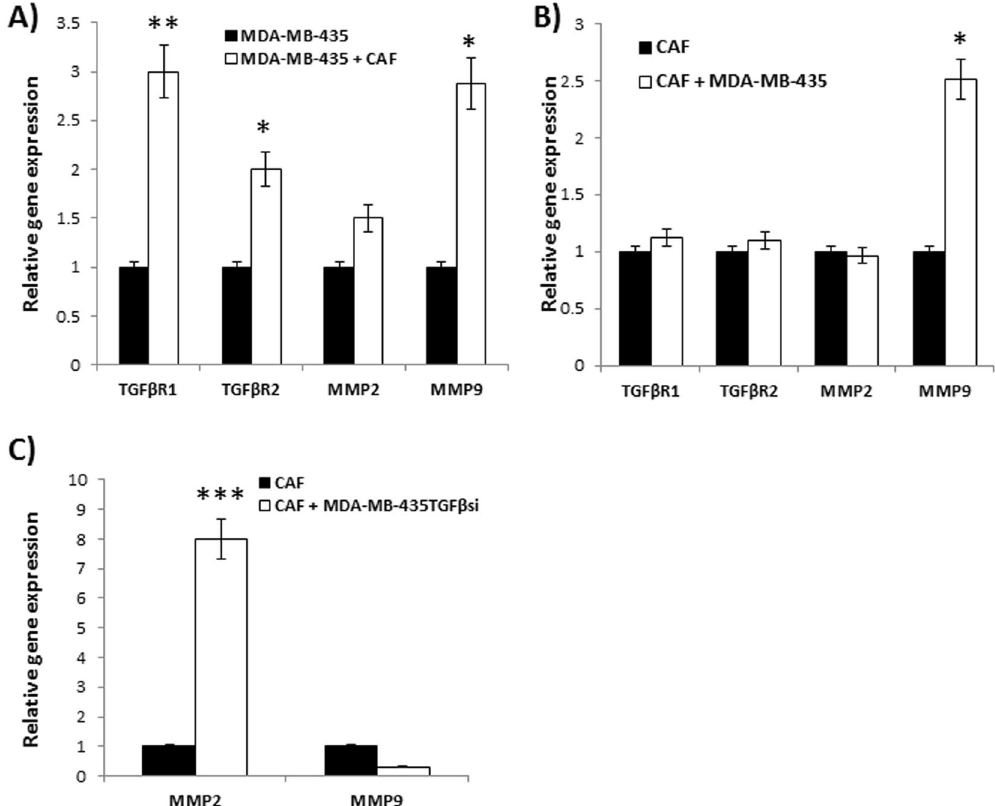
Figure 4. Co-culture assays to determine the effects of paracrine signaling on tumor and stromal cell gene expression. MDA-MB-435 cells and MDA-MB-435 TGF- β si cells were co-cultured with fibroblasts in Boyden chambers. Forty-eight hrs later, RNA was collected from both the tumor and fibroblasts for RT-PCR analysis of TGF- β 1, TGF- β 2, TGF- β 3, TGF β RI, TGF β RII, MMP-2 and MMP-9 gene expression levels. Values provided in ( A ) indicate gene expression from MDA-MB-435 cells, grown with CAFs; ( B ) in CAFs, grown with MDA-MB-435 cells; ( C ) in CAFs, grown with MDA-MB-435TGF β si cells. * p < 0.05; ** p < 0.01; *** p <